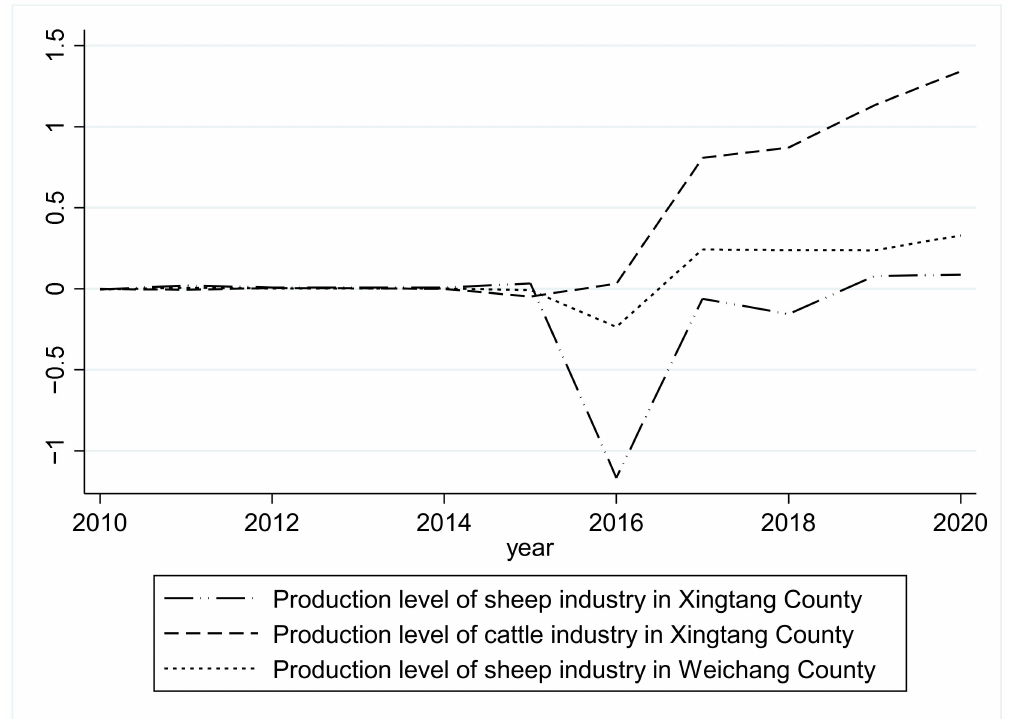
Figure 11. Effect of the CFFP on various industries’ production